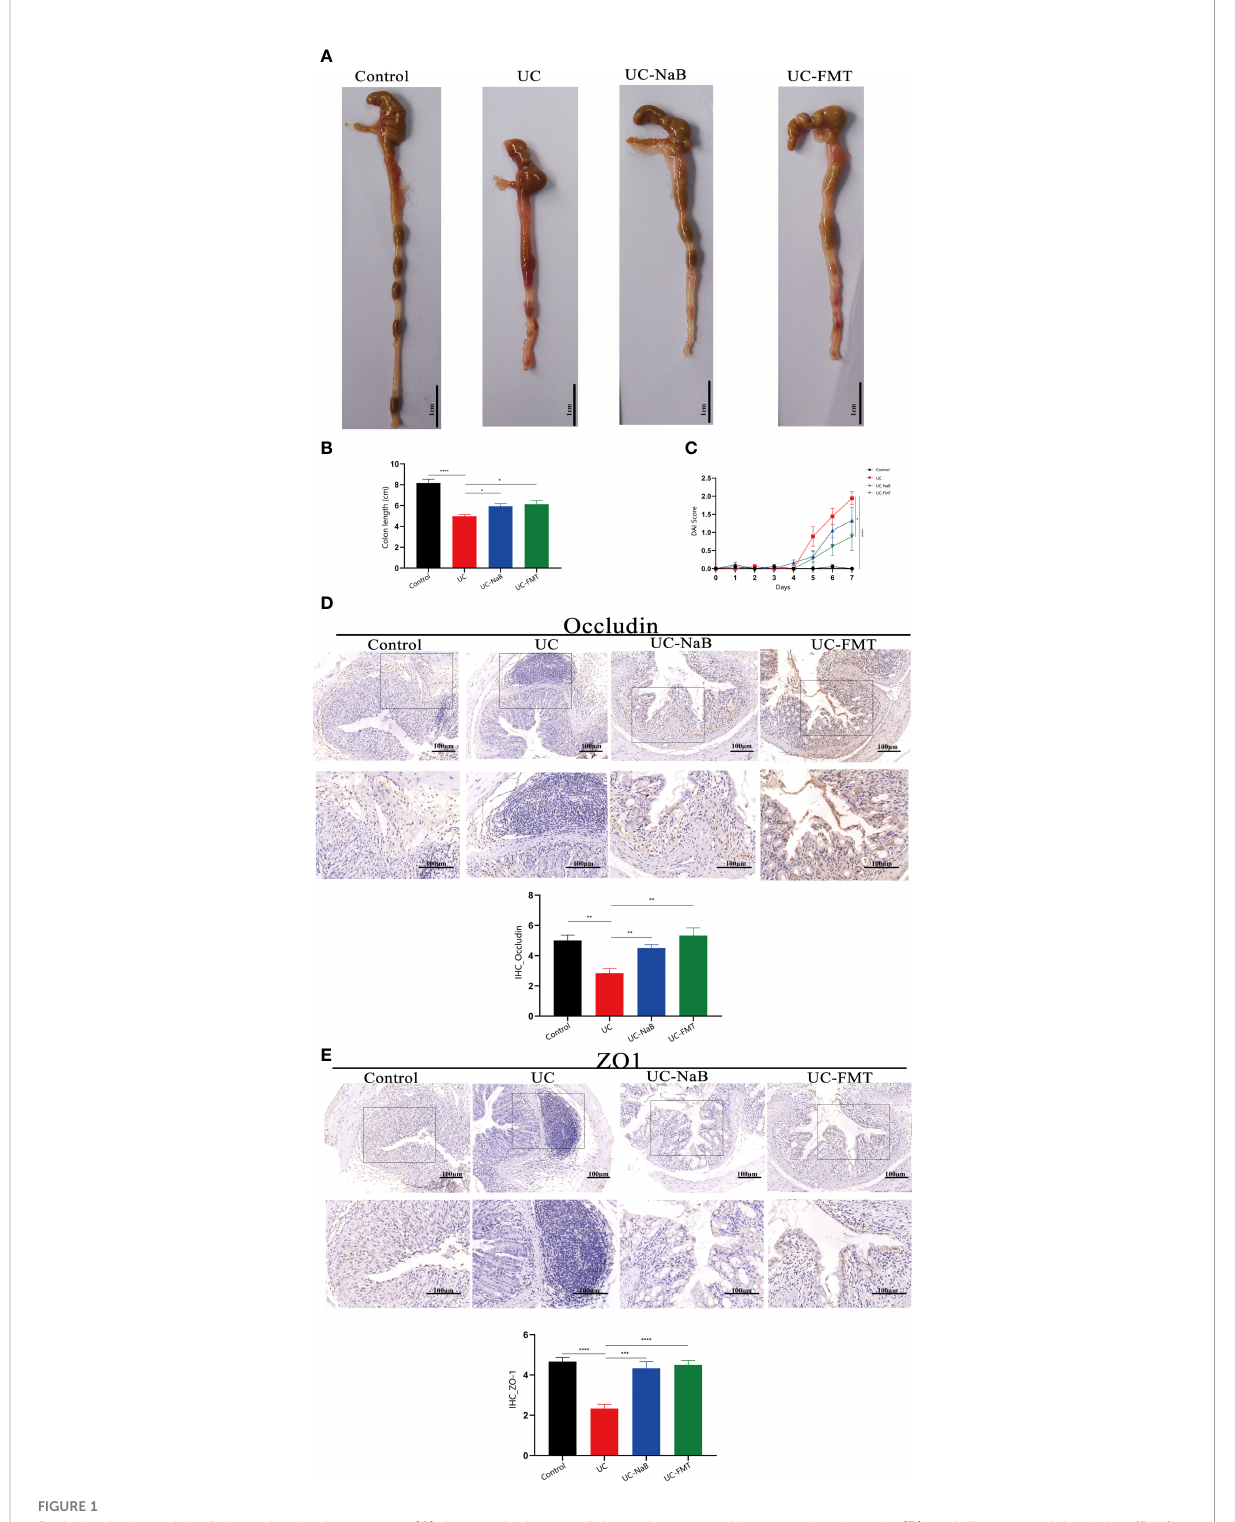
FIGURE 1 Pathological model of the colon in the mouse. (A) Anatomical map of the colorectum. Mouse colon lengths (B) and disease activity index (DAI) (C) in each group. Occludin (D) and ZO1 (E) expression in colonic tissues. * p <0.05, ** p <0.01, *** p <0.001, **** p